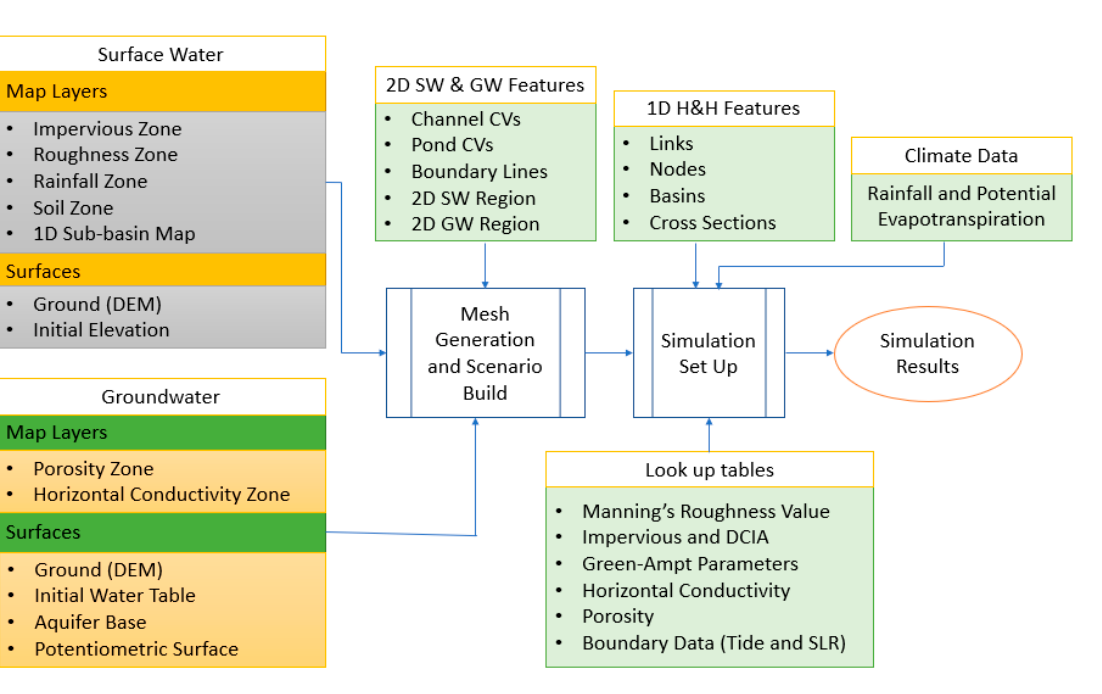
Figure 3. General structure and primary features of the ICPR 2D model. DEM, digital elevation model; H&H, hydrologic and hydraulic; DCIA, directly connected impervious area; SLR, sea level rise; SW, surface water; GW, groundwater; CV, control volume.